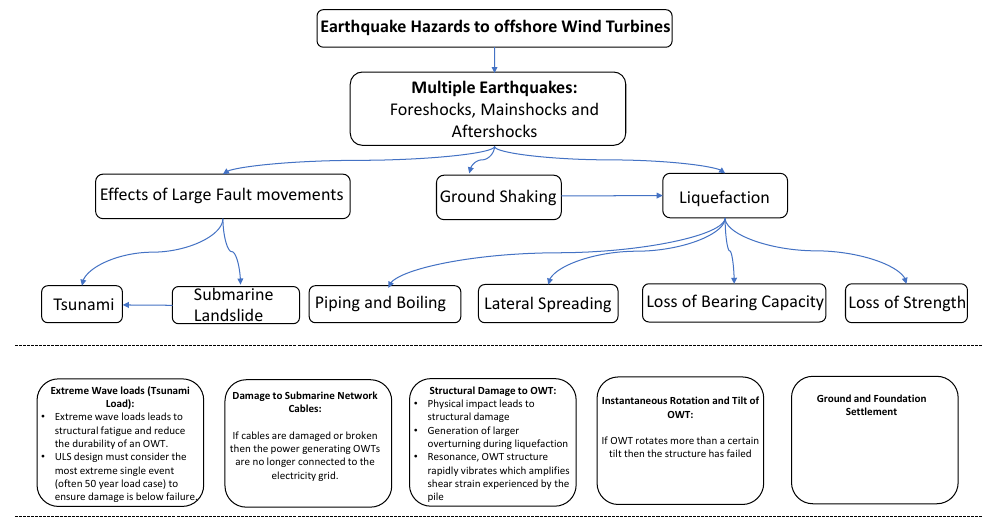
Figure 6. Earthquake hazards to a wind farm.